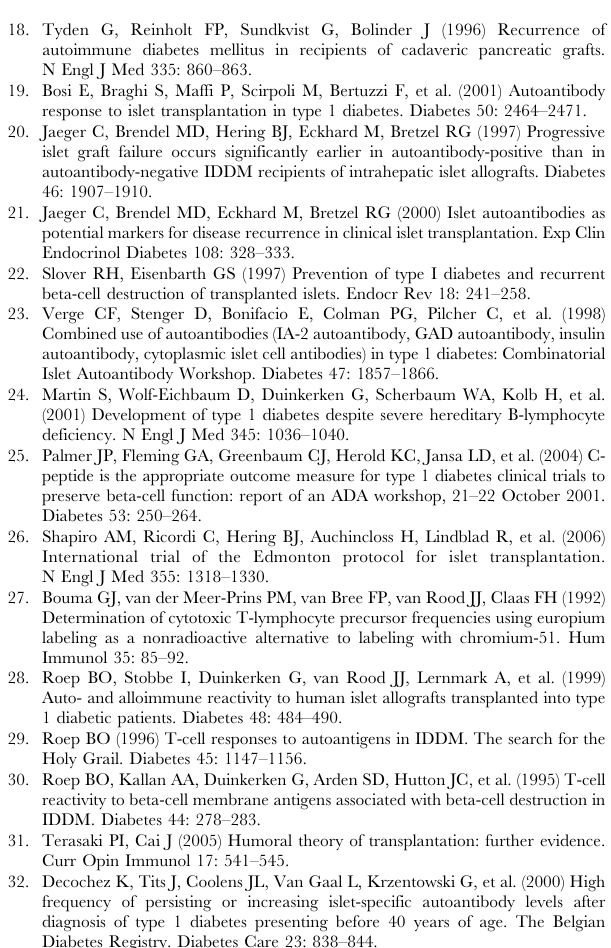
Figure S1 Stimulation Indices of pre-transplant proliferation against GAD (grey) or IA-2 (black) of patients that were insulin independent at one year (A); patients reaching insulin-indepen- dence that was lost before week 52 (B); and patients that